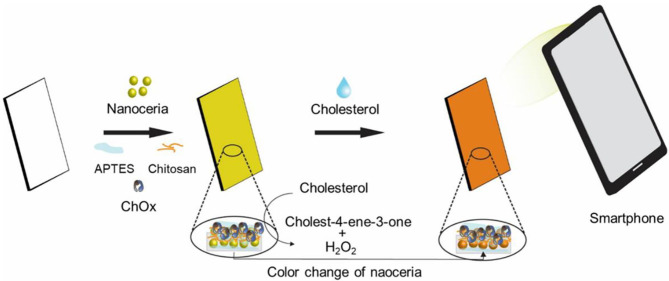
Schematic illustration of the paper strip incorporating nanoceria and ChOx for the smartphone-mediated reagent-free colorimetric determination of cholesterol.